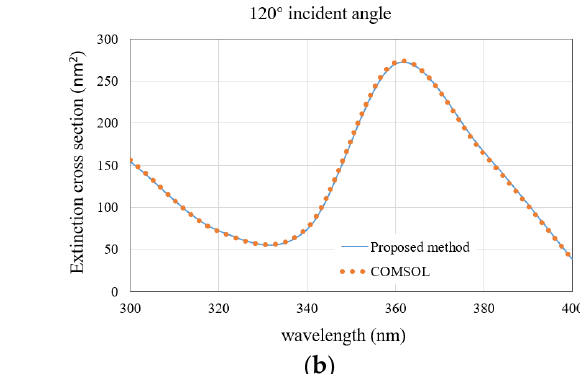
Figure 5. Comparison of the ECS results obtained by the proposed method and the COMSOL software for the nanosphere array. ( a ) 90° incident angle; ( b ) 120° incident angle.